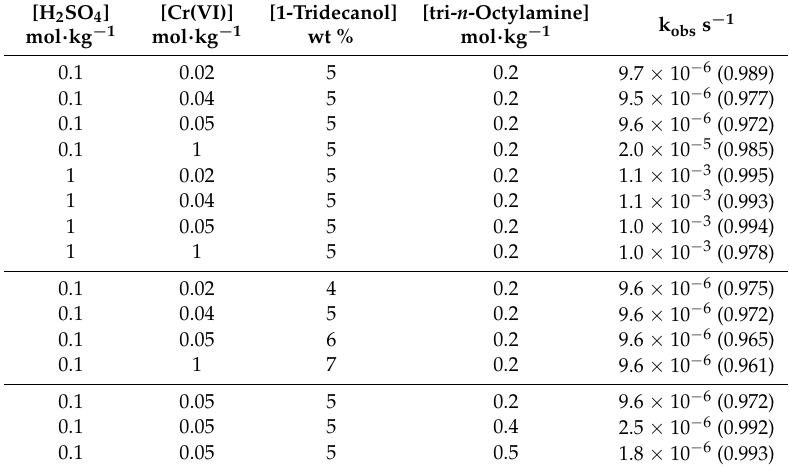
Table 3. Kinetic rates of degradation (k obs ) at 25 ◦ C for different compositions of the extraction solvent and different concentrations in sulfuric acid and Cr(VI). In parentheses: correlation